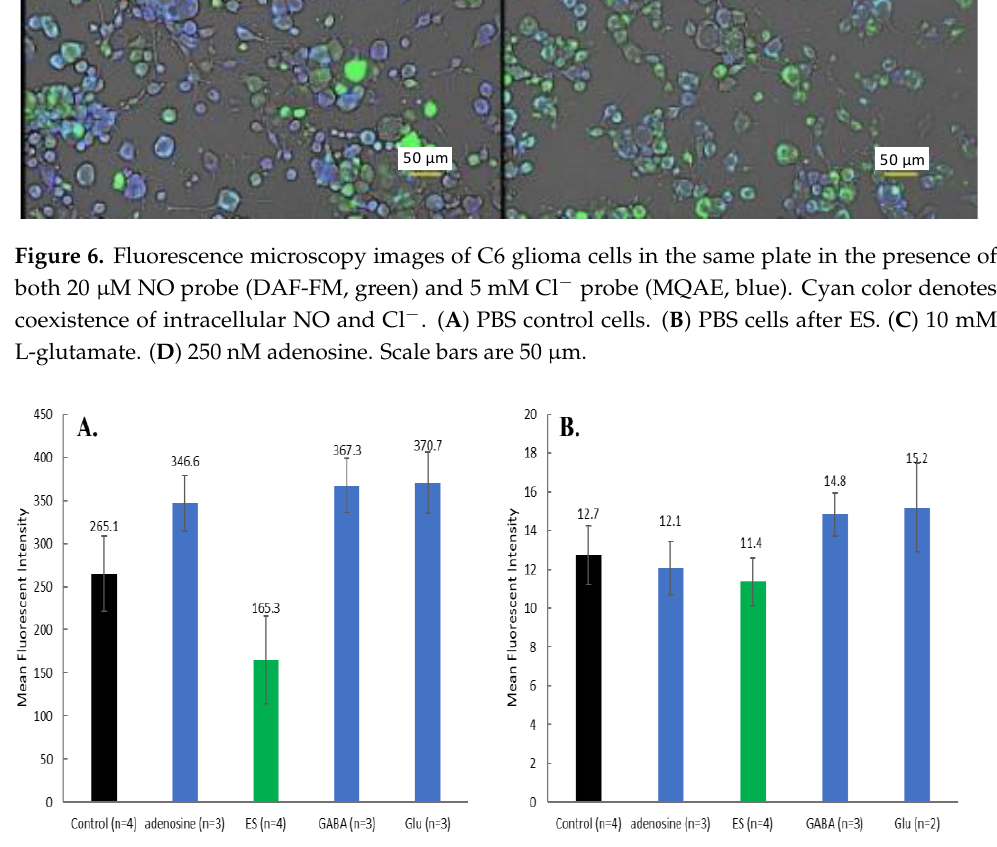
Figure 7. ( A ) Mean fluorescent intensity ± SD of DAF-FM (NO probe) averaged by condition group (Figure 2). All differences in mean intensities are significant except GABA vs. Glu by ANOVA with Tukey post hoc test ( p < 0.05). ( B ) Mean fluorescent intensity ± SD of MQAE (Cl − probe) averaged